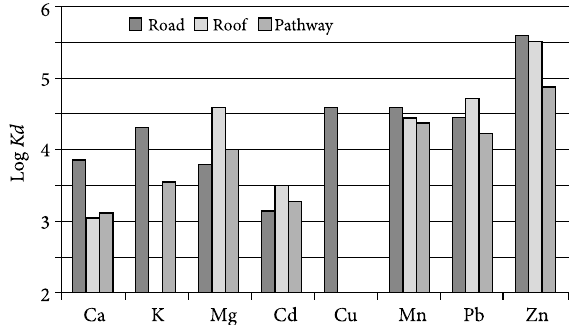
Fig. 2. Partition coefficients (log Kd) calculated for macro elements and trace metals in the urban storm water runoff samples from the investigated